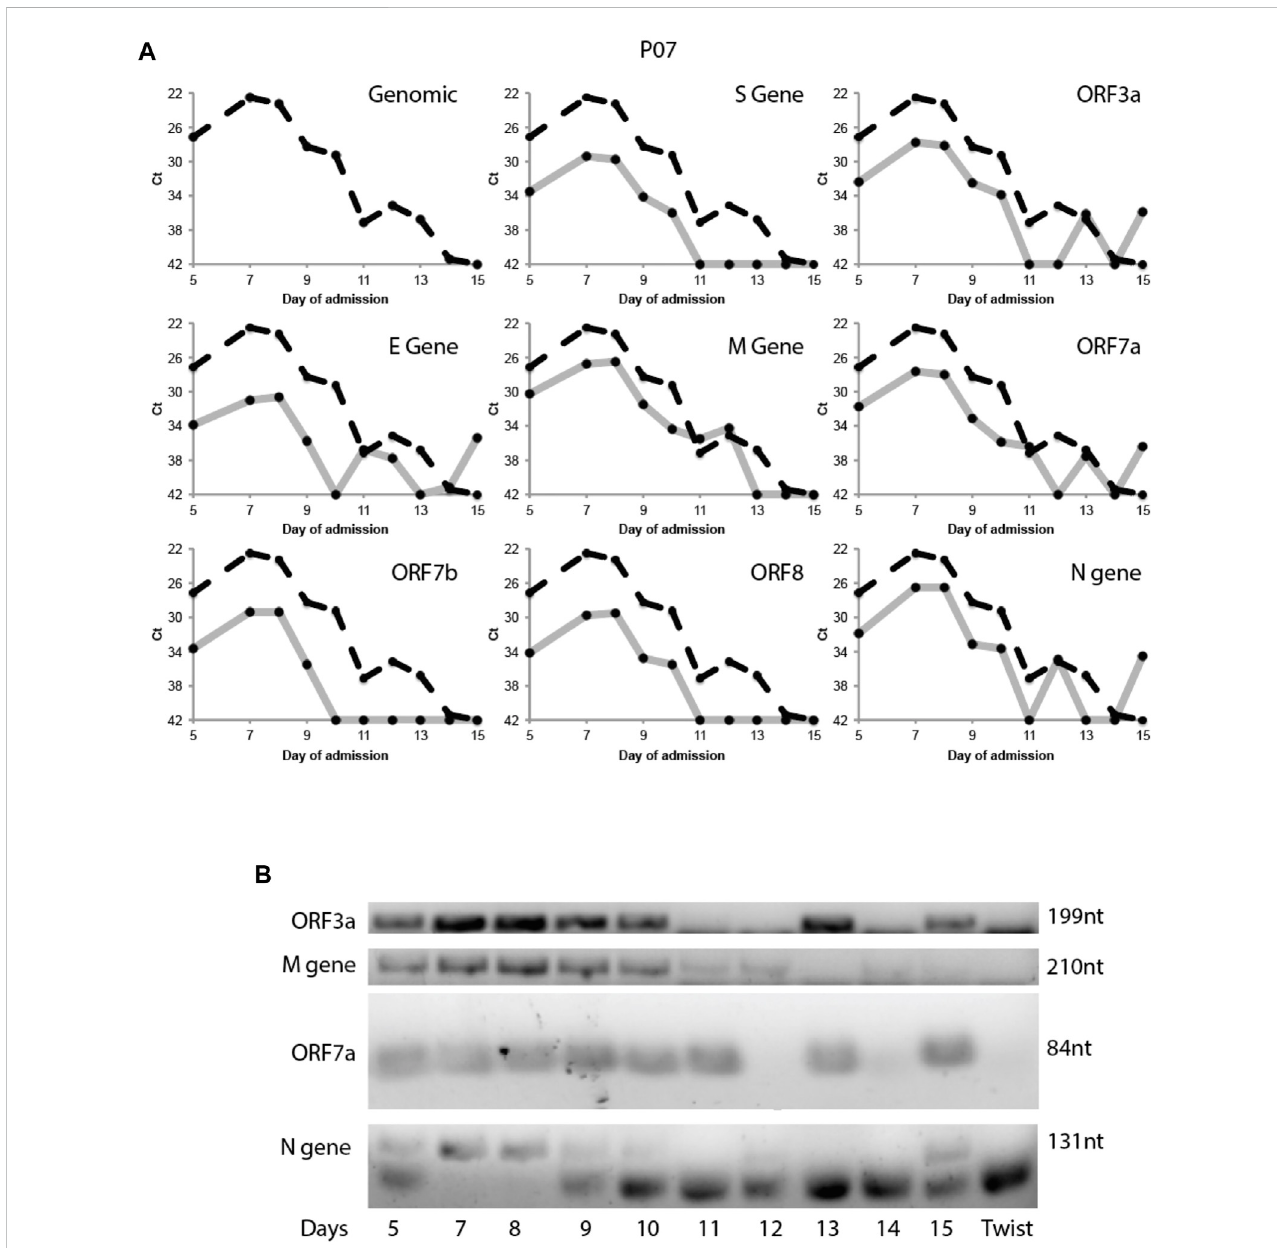
FIGURE 5 Tracking Patient 07 subgenomic expression from nasopharyngeal swabs across days of admission. Taqman probes were used to amplify a genomic targetandeightsubgenomicRNAregionsspeci fi callytargetthediscontinuousjunction via realtimeRT-PCR. (A) TheCtvaluesofthesubgenomicRNAs(solid greyline)wereplottedacross10timepointstogetherwiththegenomicCt(dottedblackline). (B) The PCRproductoftheaboveqRT-PCRwereveri fi edbygel electrophoresis. Synthetic SARS-CoV-2 genomic RNA (TWIST Bioscience) was used as a negative